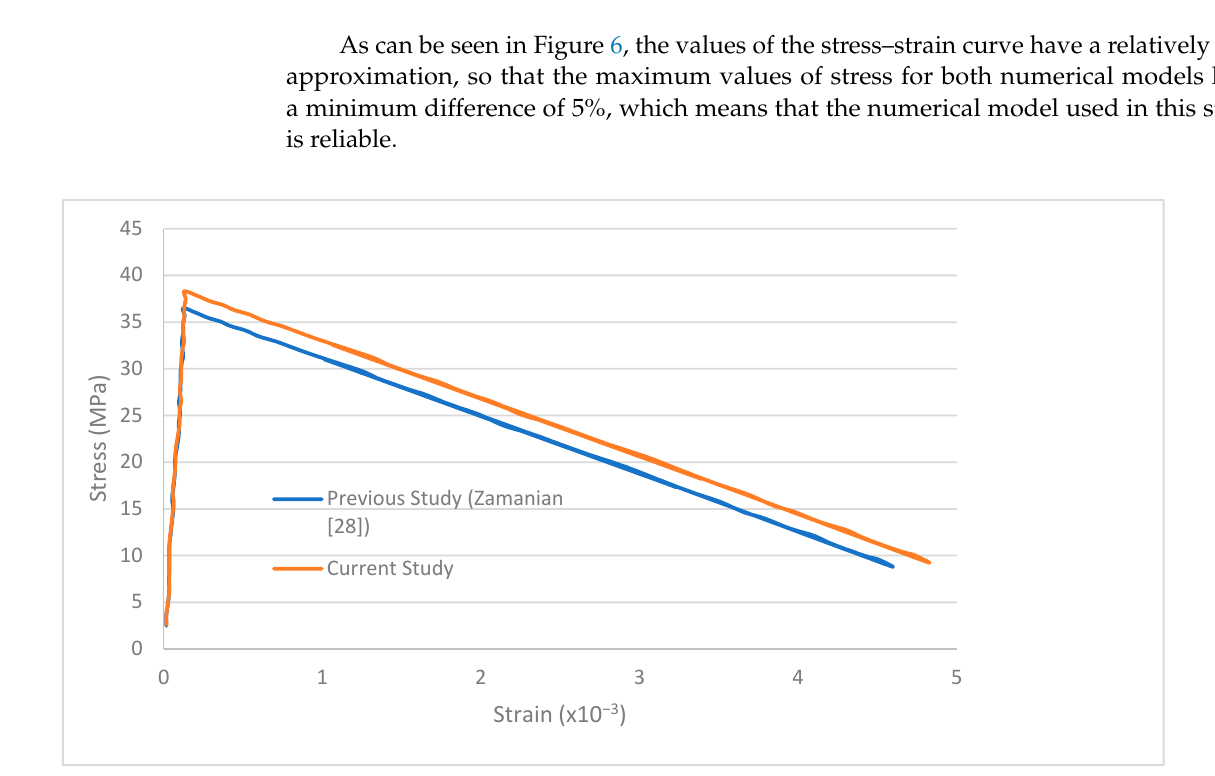
Figure 6. Verification of tensile stress–strain behavior of current study and the previous study (Zamanian [28]) depending on different element types used for soil and concrete pipe.